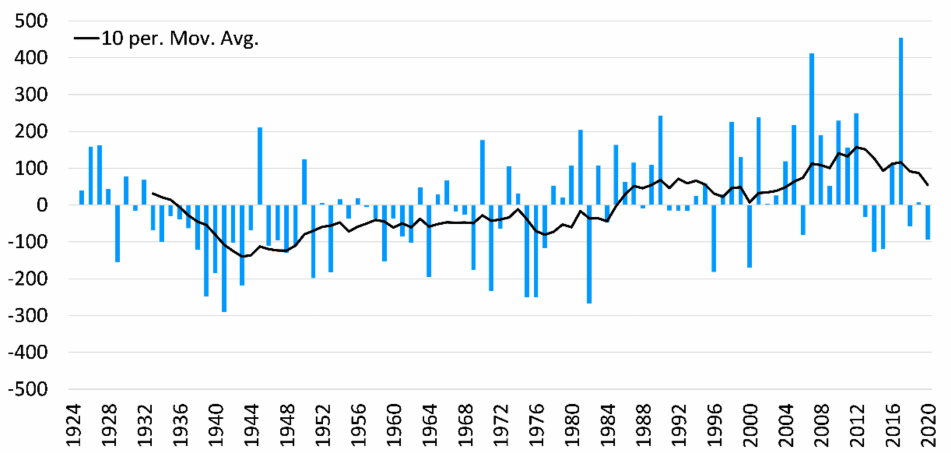
Figure 3. Anomalies of calculated (1924–1946) and observed (1947–2020) annual precipitation in Nida,